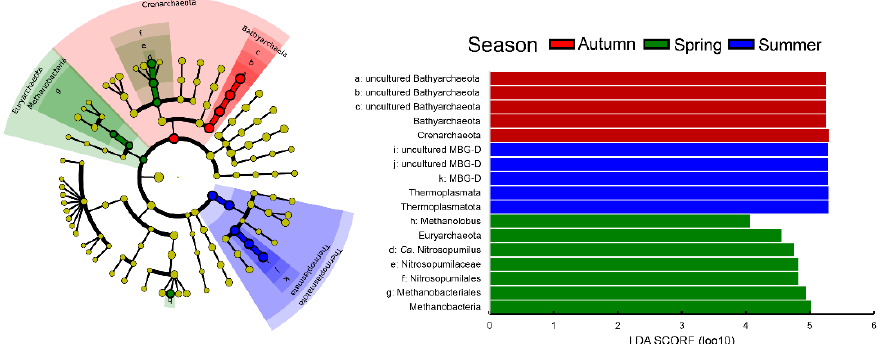
Figure 6. Taxonomic cladogram indicating the phylogenetic distribution of the archaeal lineages in terms of season categories; only lineages with linear discriminate analysis (LDA) values > 3.5 (as determined by LEfSe) are displayed ( n = 6). Circles of radiation from inside to outside indicate phylogenetic levels from phyla to genus. Phyla and classes are labeled. The diameter of each small colored circle is proportional to the relative abundance of the given taxon. Pre-sample normalization is used to standardize the relative abundance, and all-against-all strategy is used in the step of multi-class analysis.